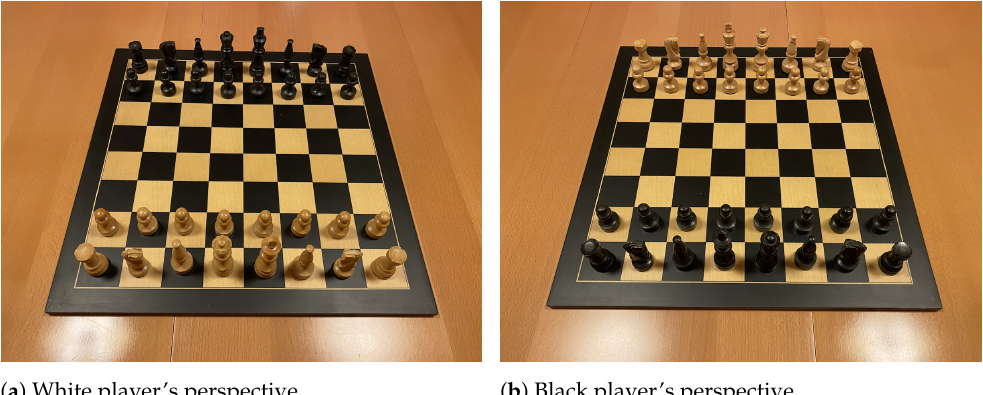
Figure 9. The two images of the unseen chess set used for fine-tuning the chess recognition system. The images require no labels because they show the starting position from each player’s perspective, thus the chess position is known. Note that unlike the large dataset used for initial training, this dataset contains photos of a real chessboard, as opposed to rendered